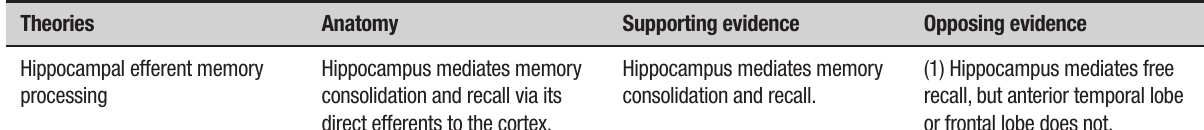
Table 1. Comparison of three theories on brain memory